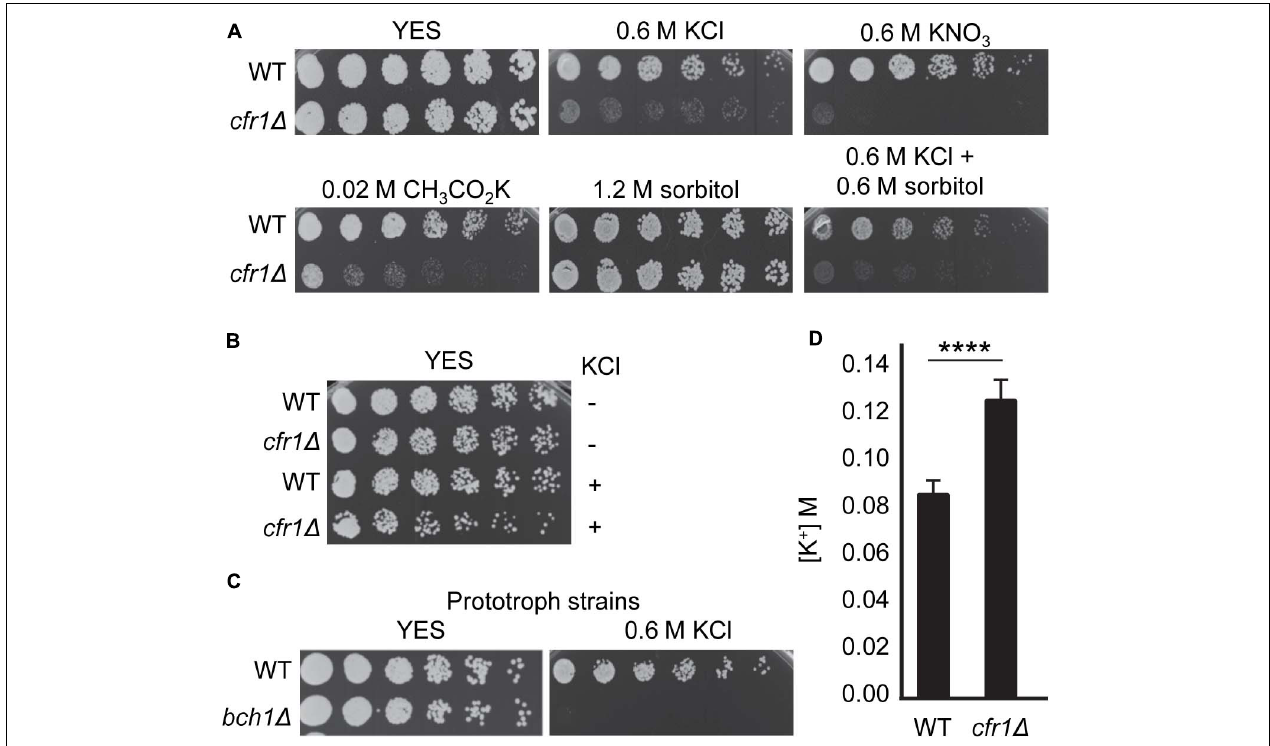
FIGURE 1 | Exomer mutants are sensitive to K + and hyperaccumulate this ion. (A) Cells from the wild-type (WT) and cfr1 (cid:49) strains were spotted on YES (rich medium) and YES supplemented with the indicated compounds. (B) Cells from the WT and cfr1 (cid:49) strains were incubated in YES medium (KCl, –) and in YES medium with 0.6 M KCl (KCl, +) for 16 h, diluted, spotted on YES plates, and incubated at 32 ◦ C for 2 days. (C) Cells from prototroph WT and bch1 (cid:49) strains were spotted on YES and YES with 0.6 M KCl. (D) Intracellular K + concentration (M) in the WT and cfr1 (cid:49) strains. For each value, the mean of three independent experiments, standard deviation, and statistical significance of the difference, determined using the t -test are shown (**** p < 0.0001).